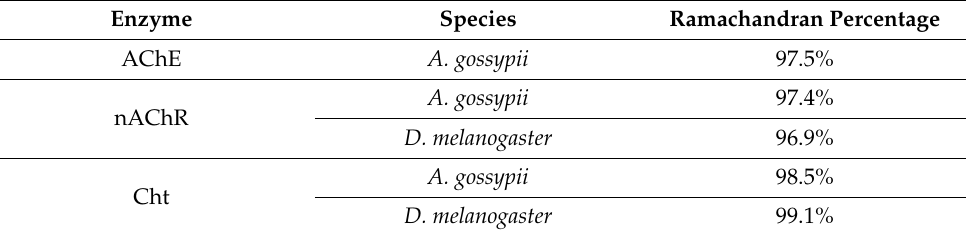
Table 1. Percentage of amino acids present in the permitted and favored regions of the Ramachandran chart for each model.